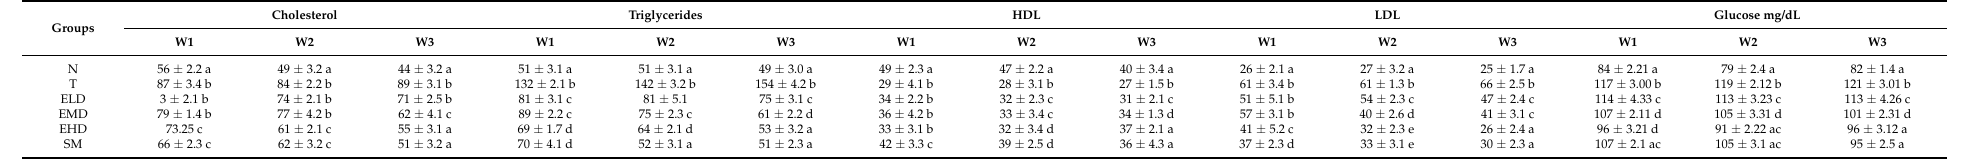
Table 4. The effects of (DO.AQ) extracts on the lipid profile of various experimental groups.